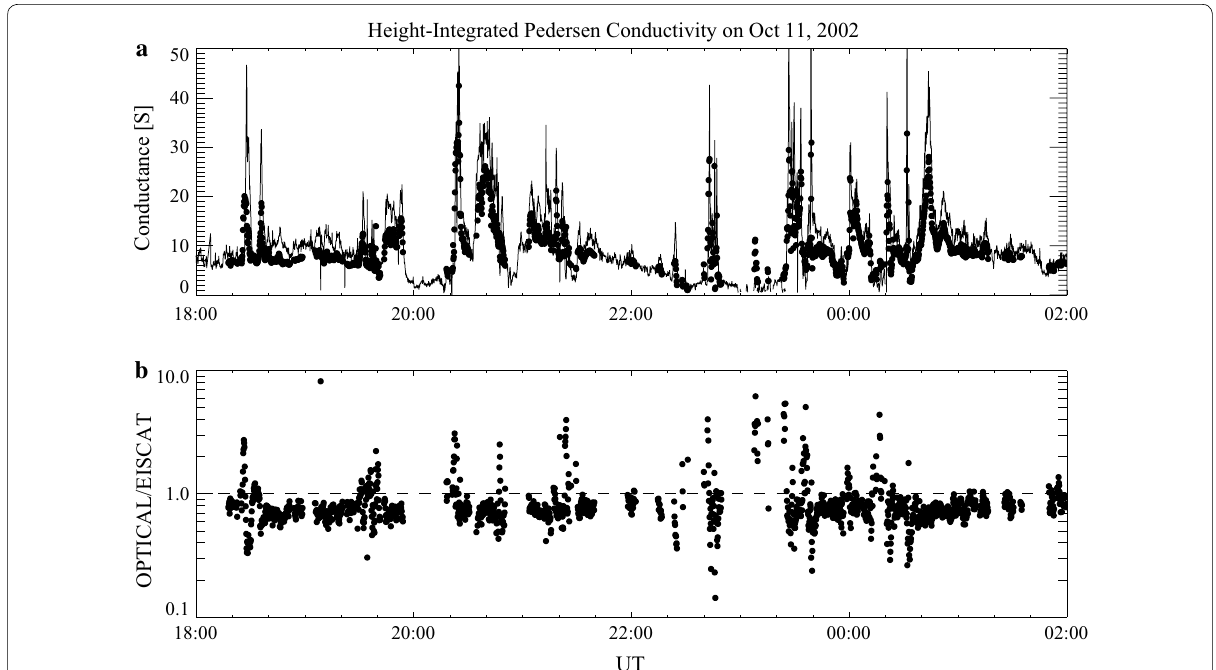
Fig. 8 Comparison of Pedersen conductivities for October 11, 2002; a temporal variations of the height-integrated Pedersen conductivities derived with the EISCAT UHF radar and the photometer observations between 18:00 UT on October 11 and 02:00 UT on October 12, 2002. b Temporal varia- tions of the ratio of the height-integrated Pedersen conductivities from the photometric to radar values